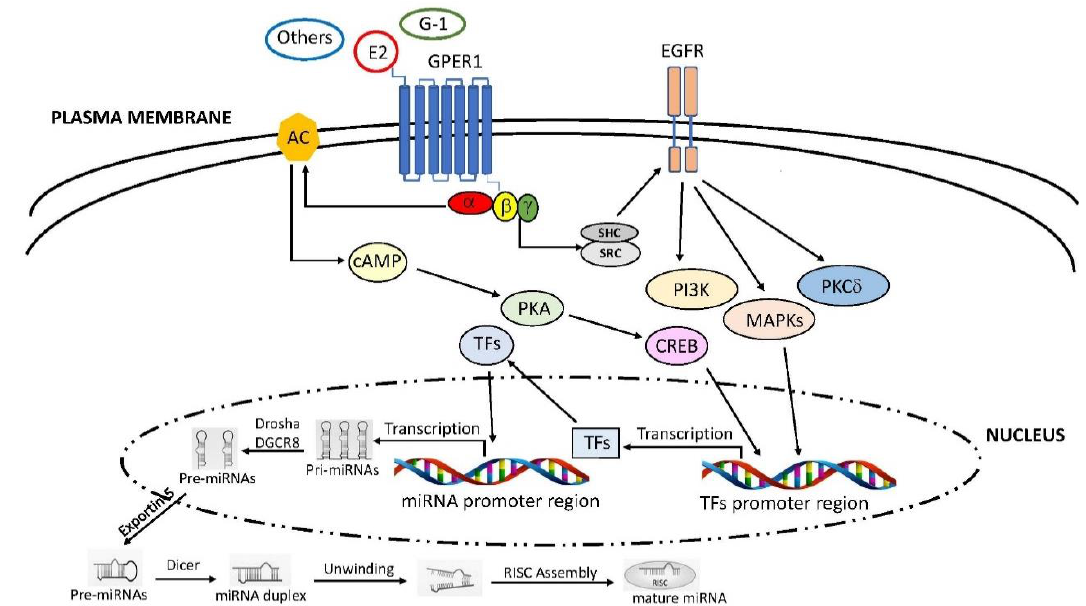
Figure 2. Schematic representation of GPER1 involvement in the regulation of miRNA expression. Ligand-binding to GPER1 leads to activation of SRC through the β and γ subunits of the G protein. The complex SRC tyrosine kinase-SHC adapter protein triggers the EGFR transactivation, which, in turn, stimulates downstream pathways, like PI3K, MAPKs and PKC δ . In addition, GPER activation stimulates the activity of AC through the G α subunit, leading to the PKA-mediated increase of CREB. Both signalling may trigger the expression of specific TFs involved in miRNA transcription. In the nucleus miRNAs are processed and exported in cytoplasm, where they become mature miRNAs. SRC: steroid receptor coactivator; EGFR: epidermal growth factor receptor; PI3K: phosphatidylinositol 3-kinase; PKCδ: phospho-kinase C delta; AC: adenylyl cyclase; PKA: phospho-kinase A; CREB: cAMP response element-binding protein; TFs: transcription factors. Further abbreviations are addressed in the text.